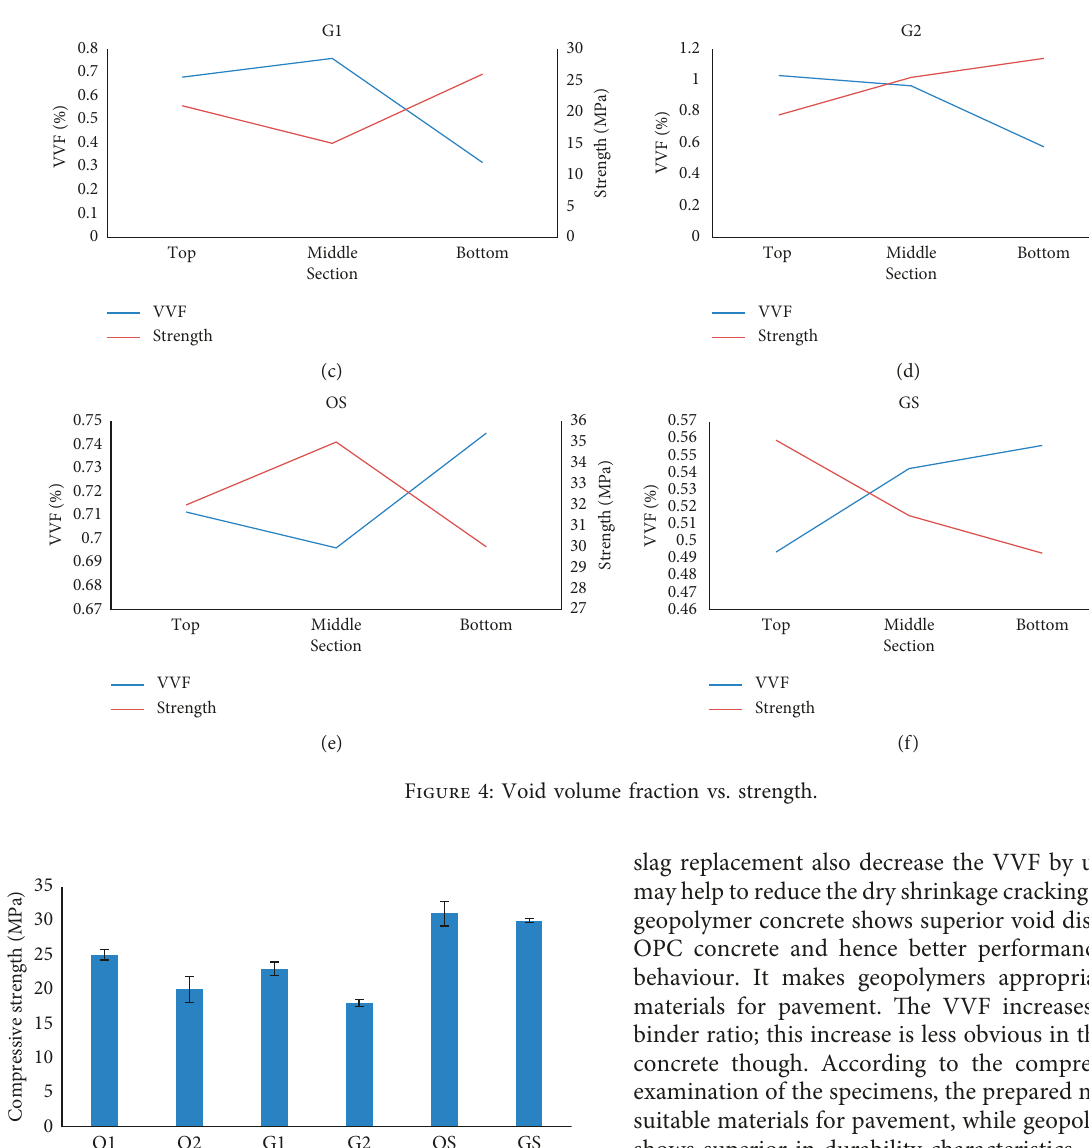
Figure 5: Compressive strength of the concrete cylinders.